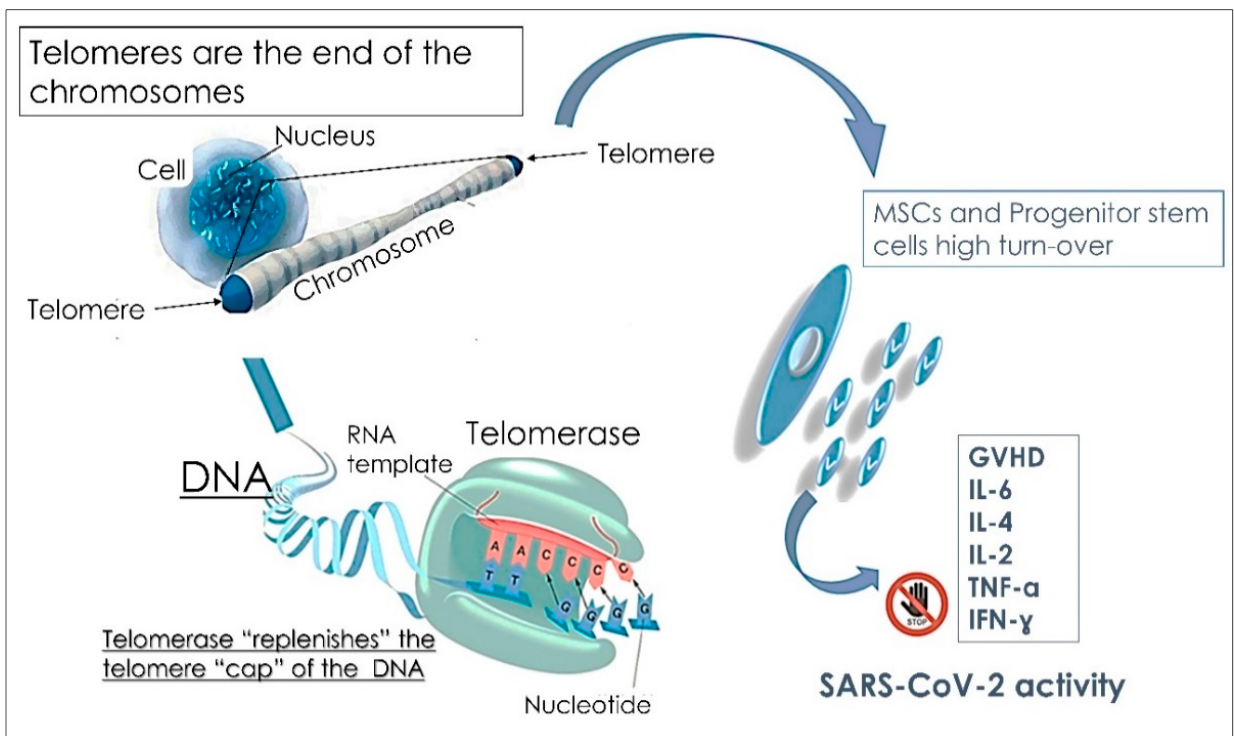
Figure 2. Schematic representation of telomeres as a key factor in sustaining MSCs and progenitor stem cell proliferation, thus leading to their anti-inflammatory effect by blocking the production of pro-inflammatory cytokines (IL-6, TNF- α , IFN- γ ). [interleukin: IL; tumor necrosis factor- α : TNF- α ; Interferon gamma: IFN- γ ; graft versus host disease: GVHD]